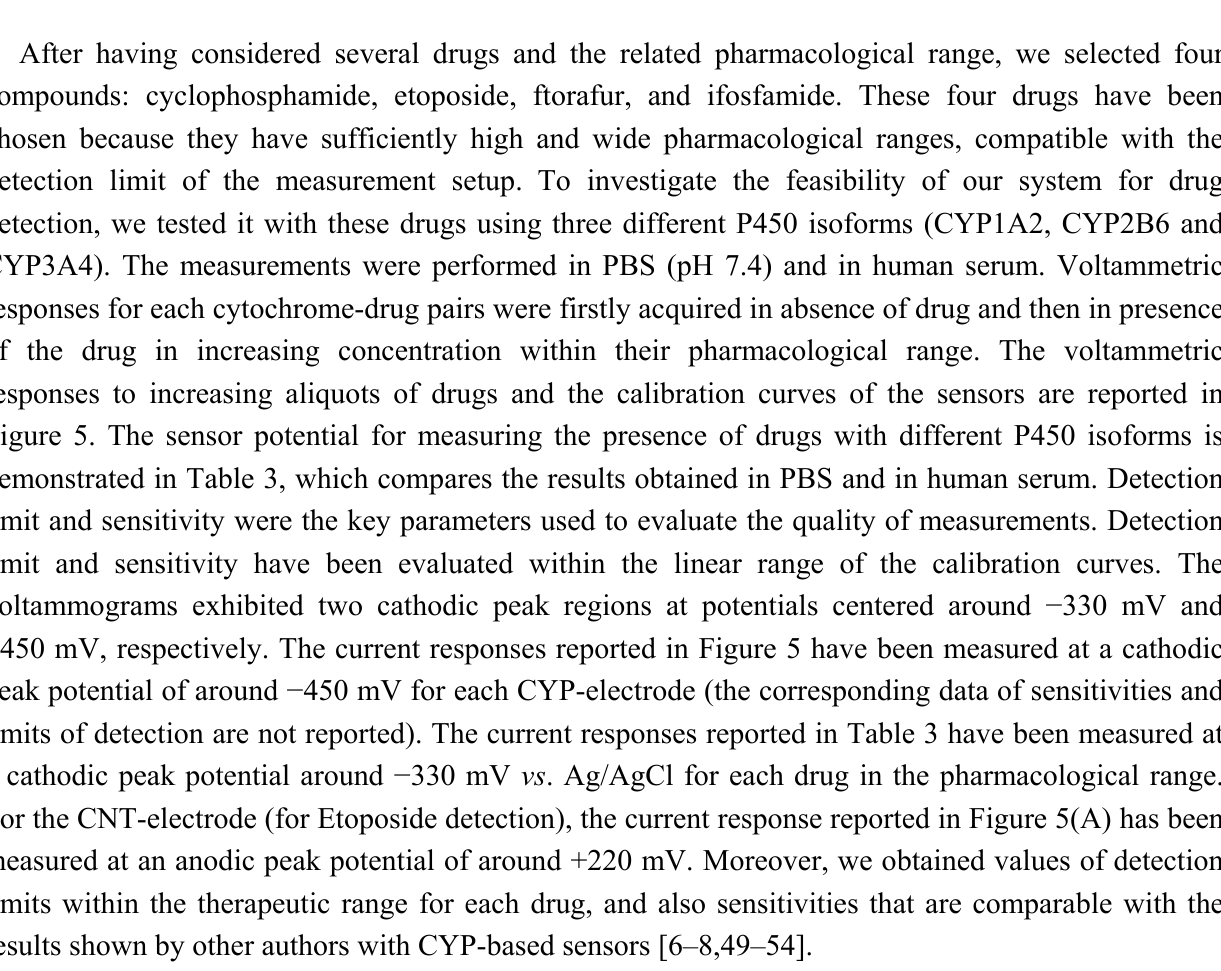
Figure 5. Cyclic voltammetric responses (on the left) and calibration curves (on the right), obtained from cyclic voltammetric measurements in PBS with increasing aliquots of